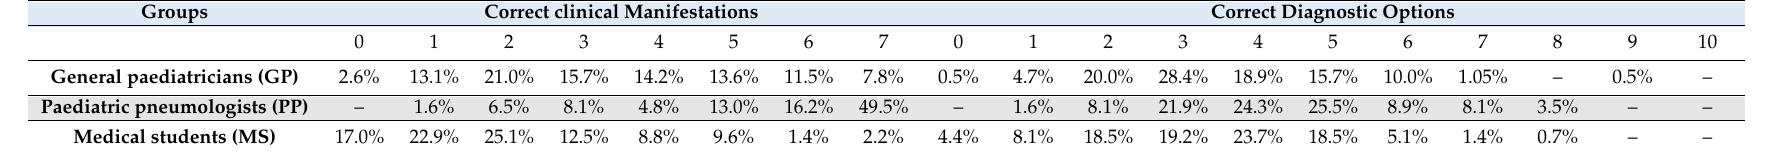
Table 3. Correct answers to primary ciliary dyskinesia (PCD) knowledge questionnaire.